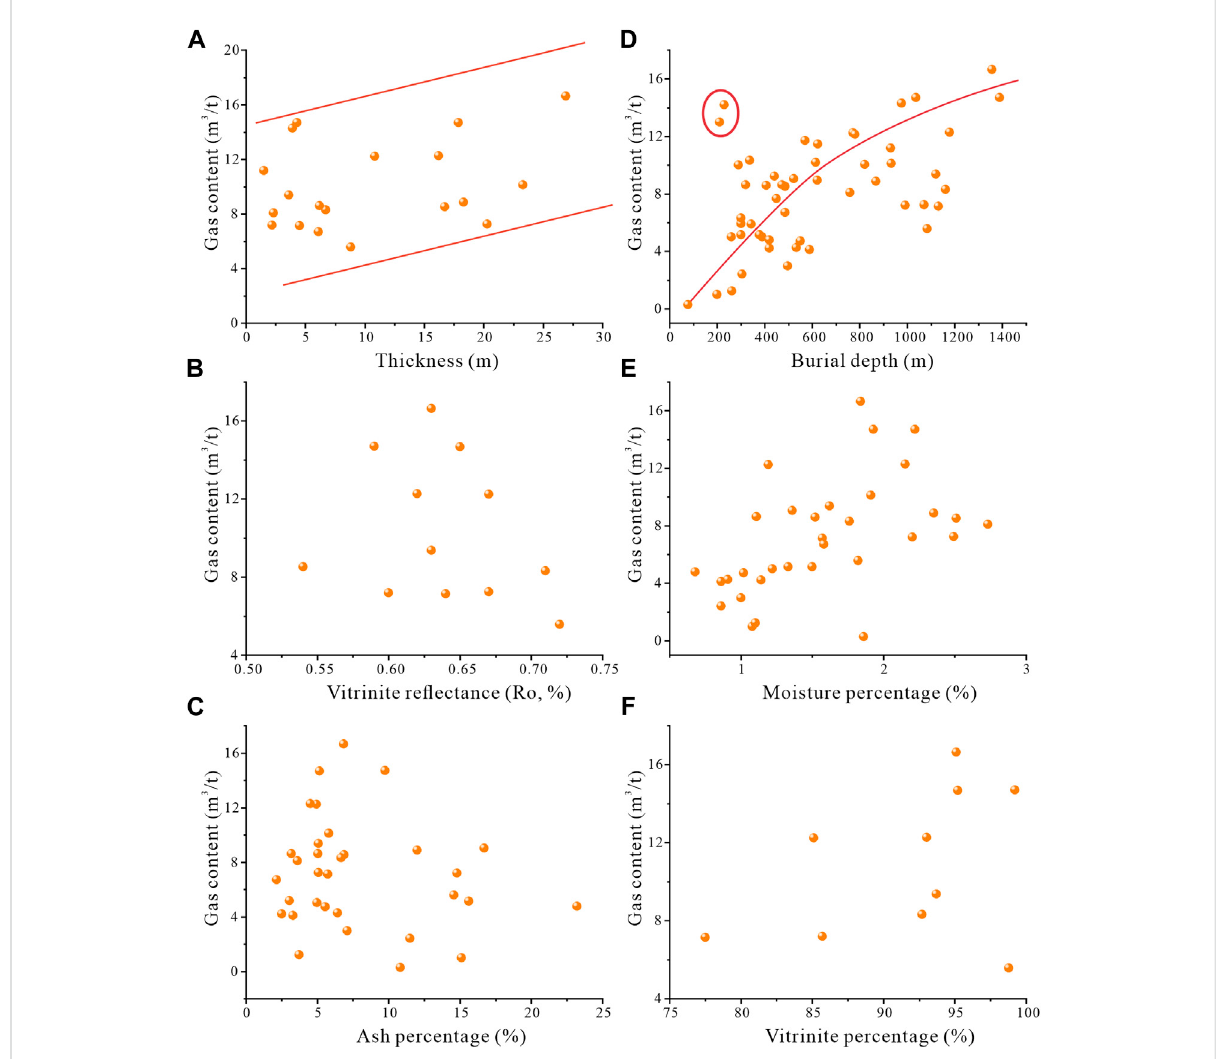
FIGURE 9 Correlations of gas content with coal thickness (A) , vitrinite re fl ectance (B) , ash percentage (C) , burial depth (D) , moisture percentage (E) , and vitrinite percentage (F) .